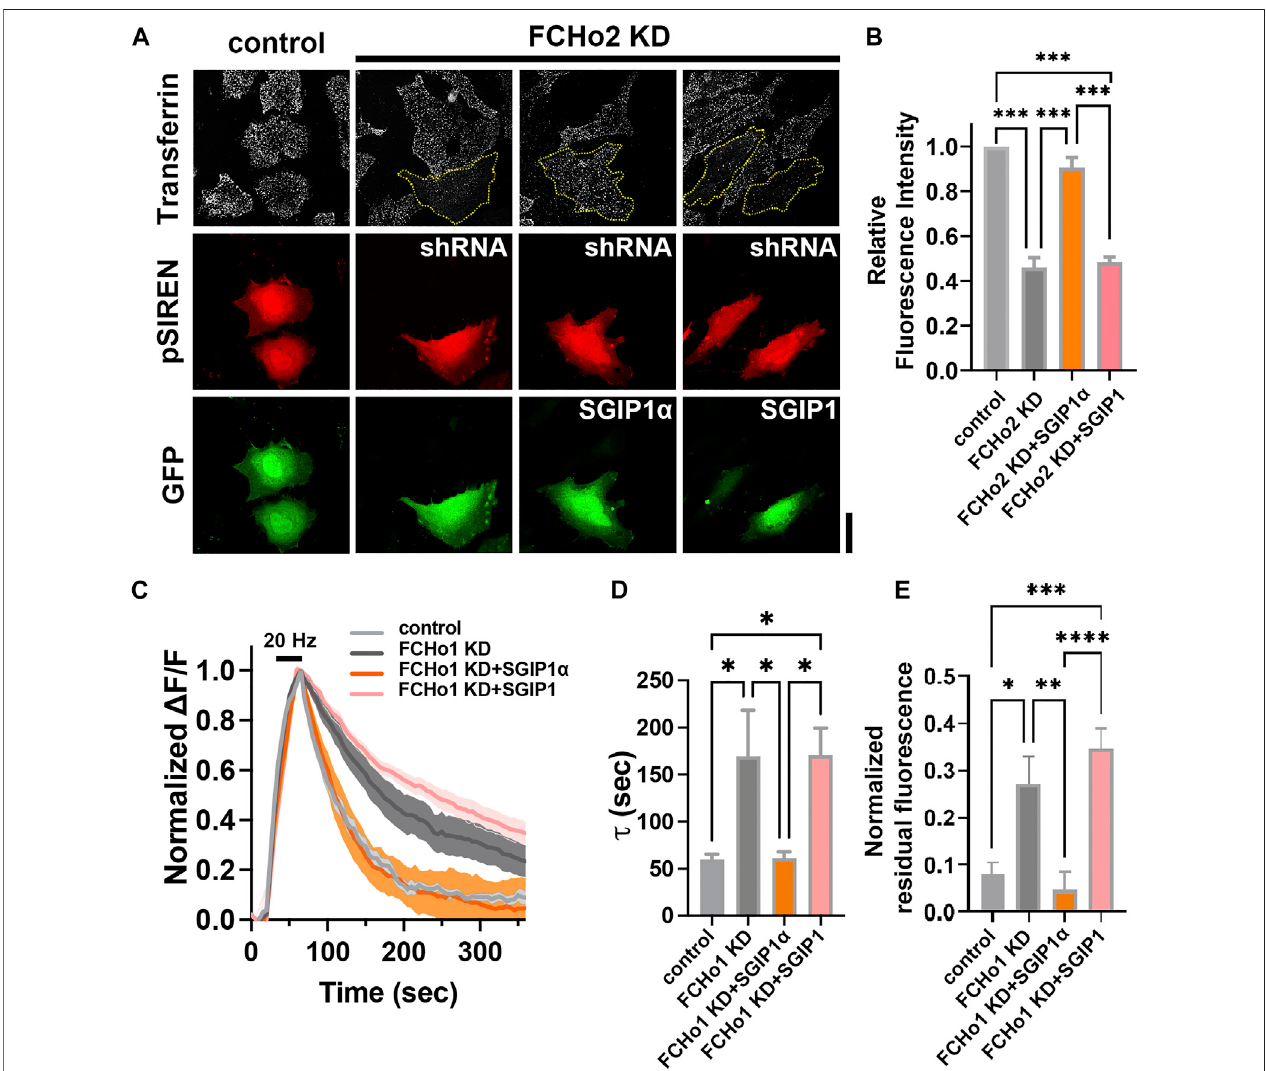
FIGURE4| SGIP1 α , not SGIP1, rescues the endocytic defects caused by FCHo depletion. (A) Representative fl uorescence images of transferrin uptake in HeLa cells. Yellow dotted lines indicate cells transfected with shRNA-FCHo2. Scale bar: 20 μ m. (B) A plot of relative fl uorescence signals of transferrin- Alexa647 measured at 5 min of transferrin treatment in HeLa cells in (A) . One-way ANOVA followed by Tukey ’ s HSD test. n (cid:1) 3 (15 cells per construct for each independent experiment). *** p < 0.001. Error bars indicate mean ± s.e.m. (C) Average synaptophysin1-pHluorin fl uorescence intensity pro fi les in neurons expressing each construct, plotted as Δ F/F against time, after stimulation with 900 APs at 20 Hz (dark bar). Fluorescence values were normalized to the maximal fl uorescence signal in each condition (control; n (cid:1) 9 for control; n (cid:1) 7 for FCHo1 KD; n (cid:1) 9 for FCHo1 KD + SGIP1 α ; n (cid:1) 9 for FCHo1 KD + SGIP1). (D) τ values for the decay of synaptophysin1-pHluorin in each experiment. τ (cid:1) 59.78 ± 5.49 s for the control; τ (cid:1) 169.4 ± 48.91 s for FCHo1 KD; τ (cid:1) 61.29 ± 6.81 s for FCHo1 KD + SGIP1 α ; τ (cid:1) 170.8 ± 28.63 s for FCHo1 KD + SGIP1; One-way ANOVA followed by Tukey ’ s HSD test. control and FCHo KD * p (cid:1) 0.0307, FCHo1 KD and FCHo1 KD + SGIP1 α * p (cid:1) 0.0337, FCHo1 KD + SGIP1 α and FCHo1 KD + SGIP1 * p (cid:1) 0.0191, control and FCHo1 KD + SGIP1 * p (cid:1) 0.0172. (E) The residual fl uorescence at 360 s of endocytosis in each experiment. One-way ANOVA followed by Tukey ’ s HSD test. control and FCHo1 KD * p (cid:1) 0.0148,